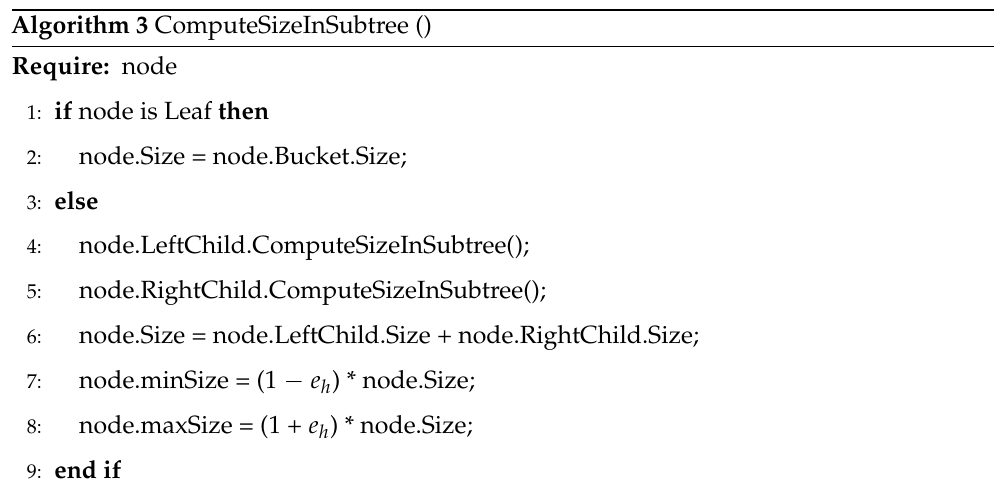
Algorithm 3 ComputeSizeInSubtree